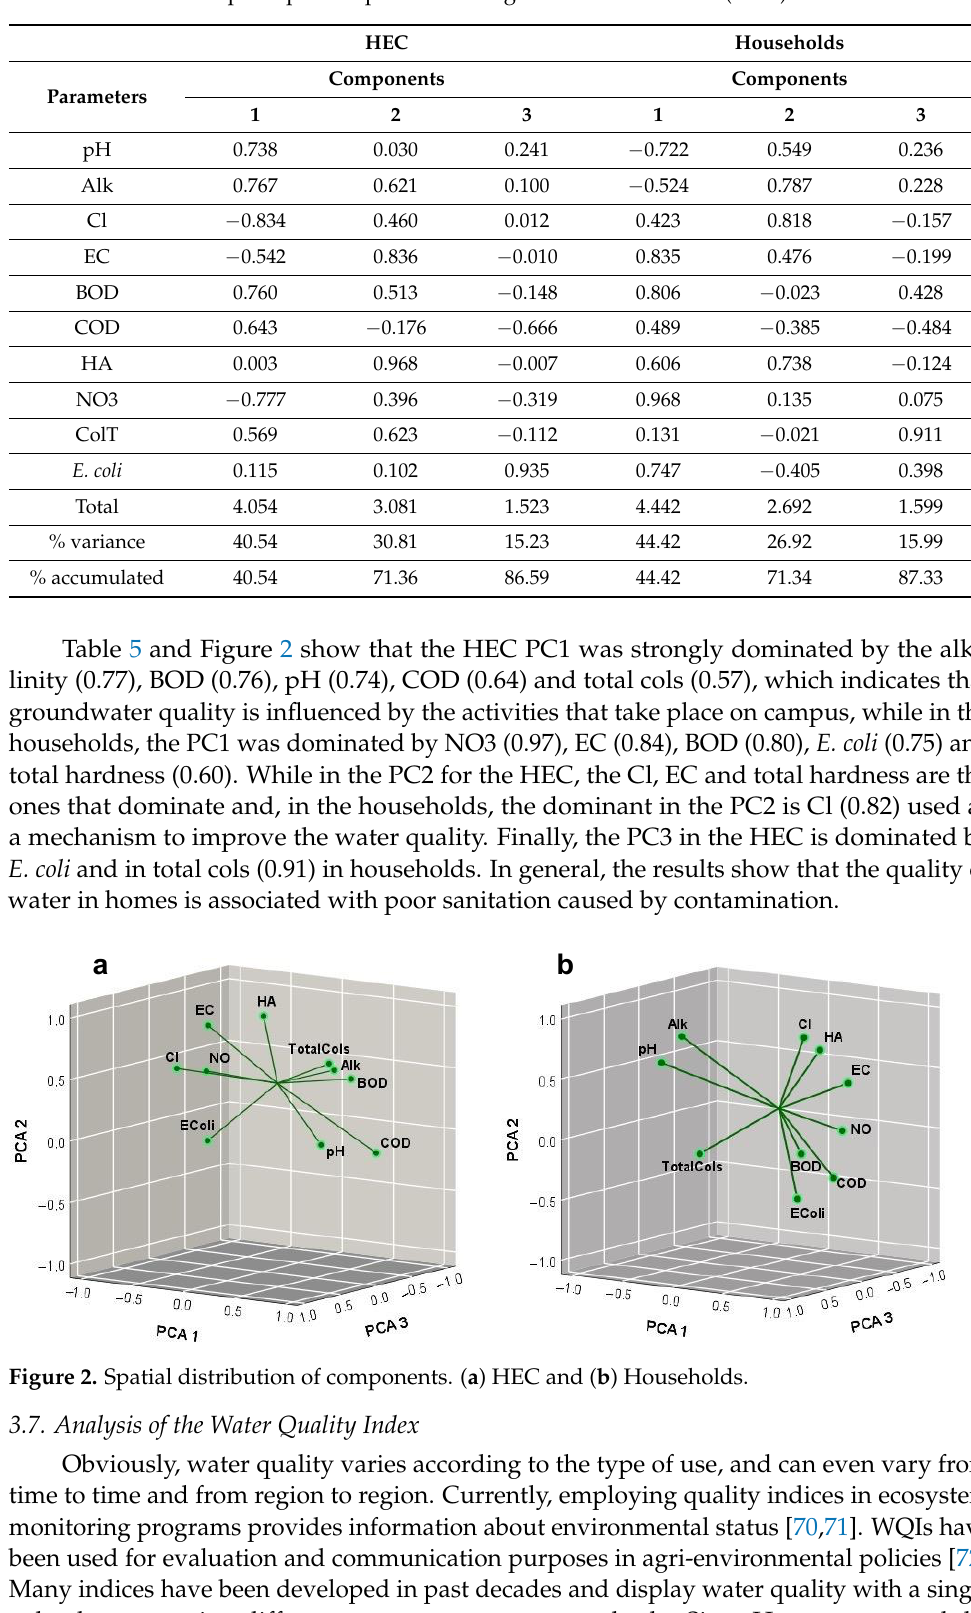
Table 5. Matrix of the principal components for higher education center (HEC) and households.